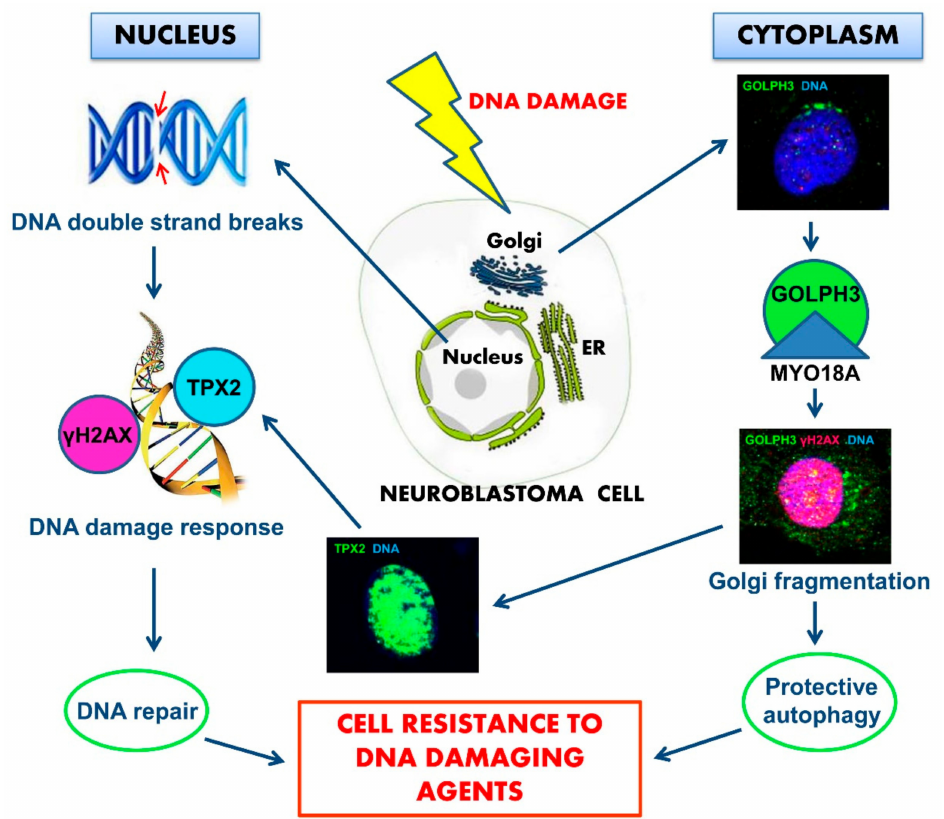
Figure 10. Schematic model of the proposed neuroblastoma (NB) cells resistance to death induced by DNA damaging agents. DNA damage agents induce chromosomal double-strand breaks in the nucleus, where chromatin is physically connected to the nuclear envelope, which is continuous with endoplasmic reticulum (ER). Membrane areas of close apposition connect ER with Golgi apparatus and with the plasma membrane. DNA double-strand breaks generate a signal leading to augmented Golgi protein GOLPH3 interaction with MYO18A, inducing Golgi dispersal and impaired intracellular tra ffi cking with functional consequences for the cell. In the cytoplasm, Golgi fragmentation is accompanied by activation of protective autophagy. In the nucleus, over-expression of TPX2 induces DNA damage response with resulting DNA repair. The combined e ff ects of the two intertwined mechanisms can support enhanced survival and NB cell resistance to